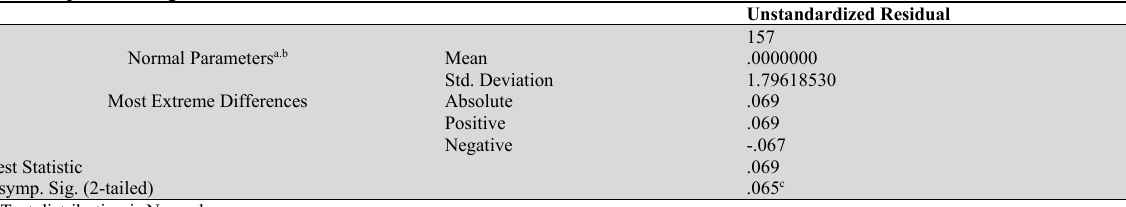
One-Sample Kolmogorov-Smirnov